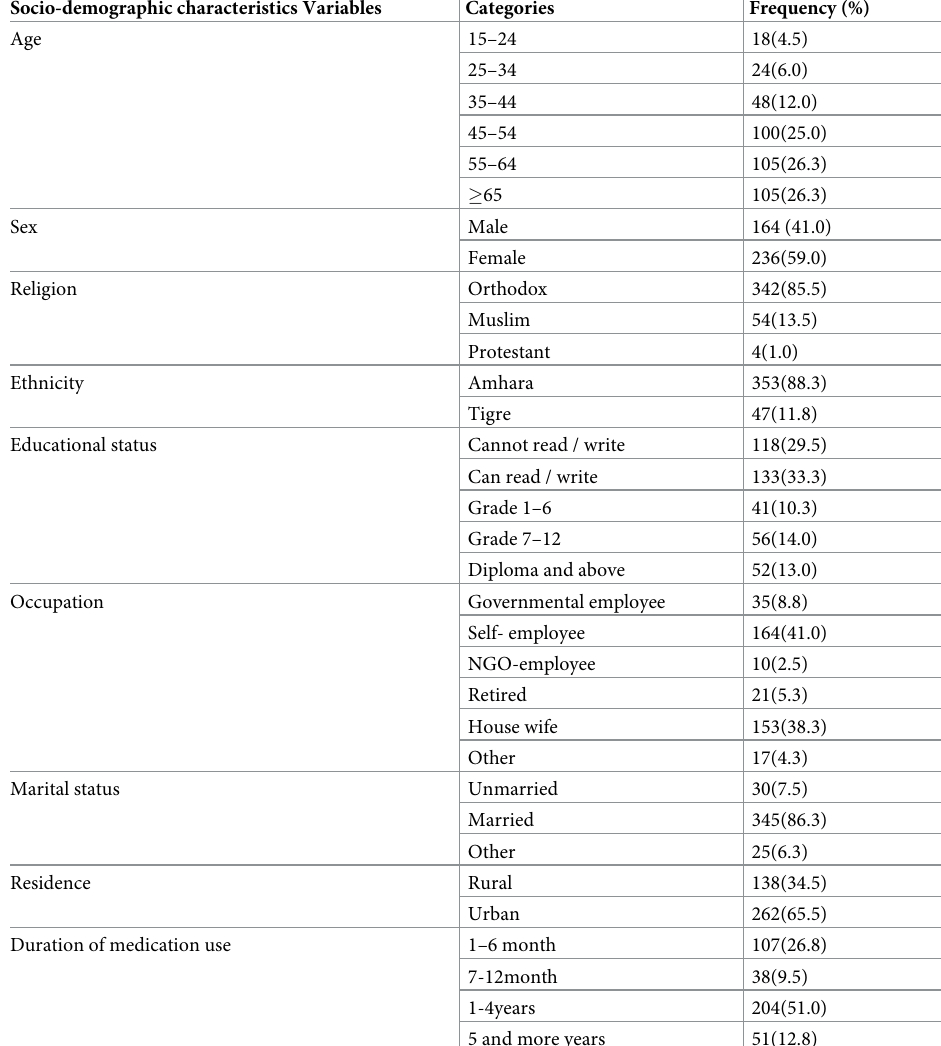
Table 1. Sociodemographic characteristics among patients with chronic disease at UoGCSH, 2021(N = 400).